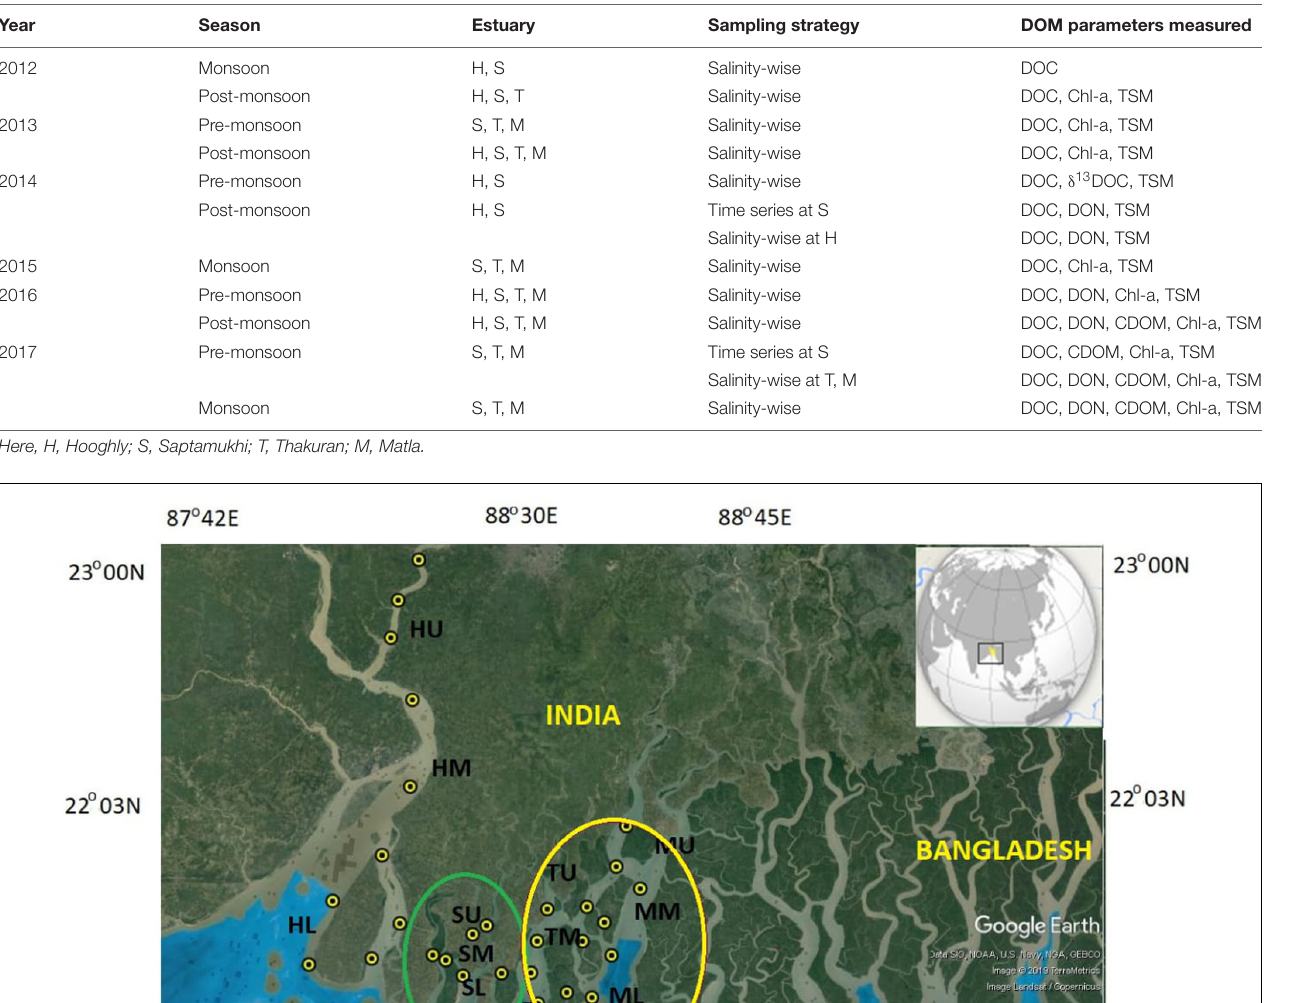
TABLE 1 | Details of spatio-temporal sampling performances during 2012–2017.